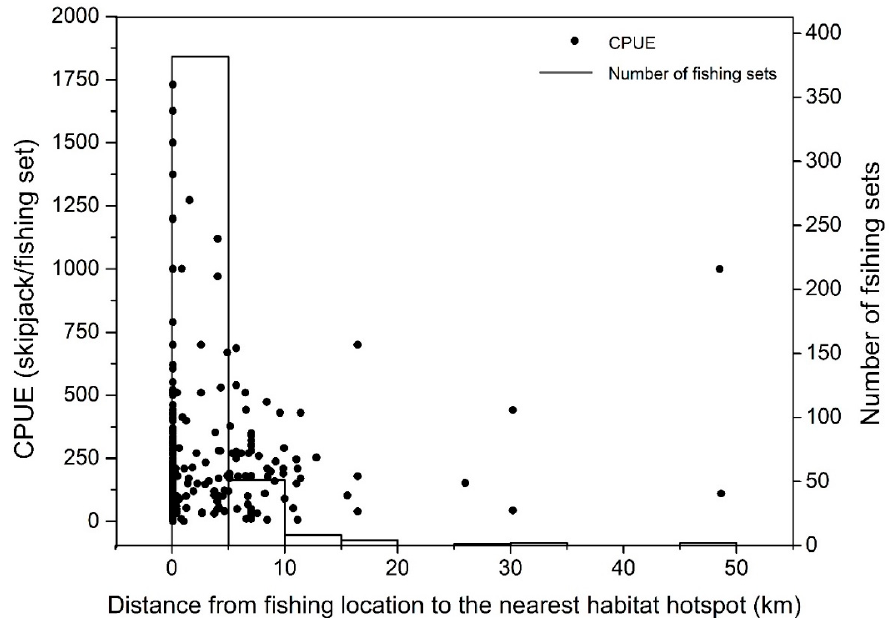
Figure 12. Catch per unit effort (skipjack/fishing set, black circles) and the number of fishing efforts (open black bars) for distance to nearest habitat hotspots with SHI ≥ 0.75 (N = 170).